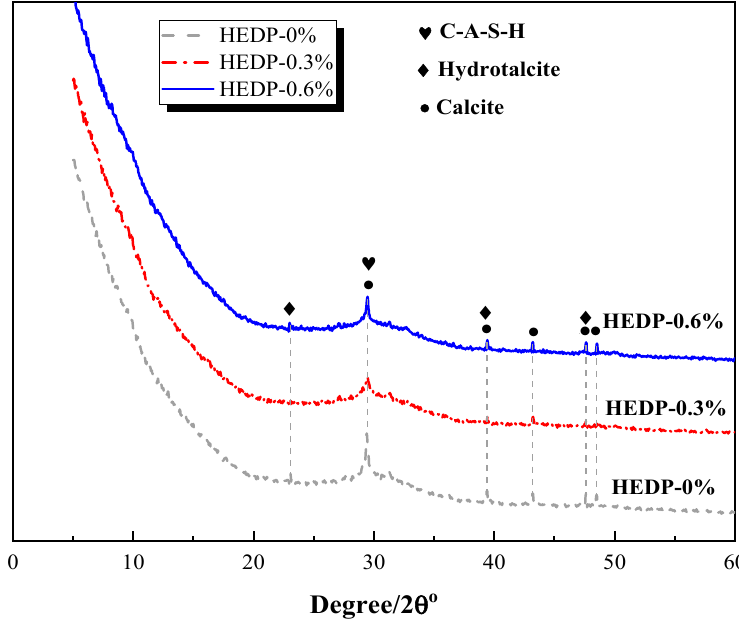
Figure 7. XRD result of 3D FR-AASC.